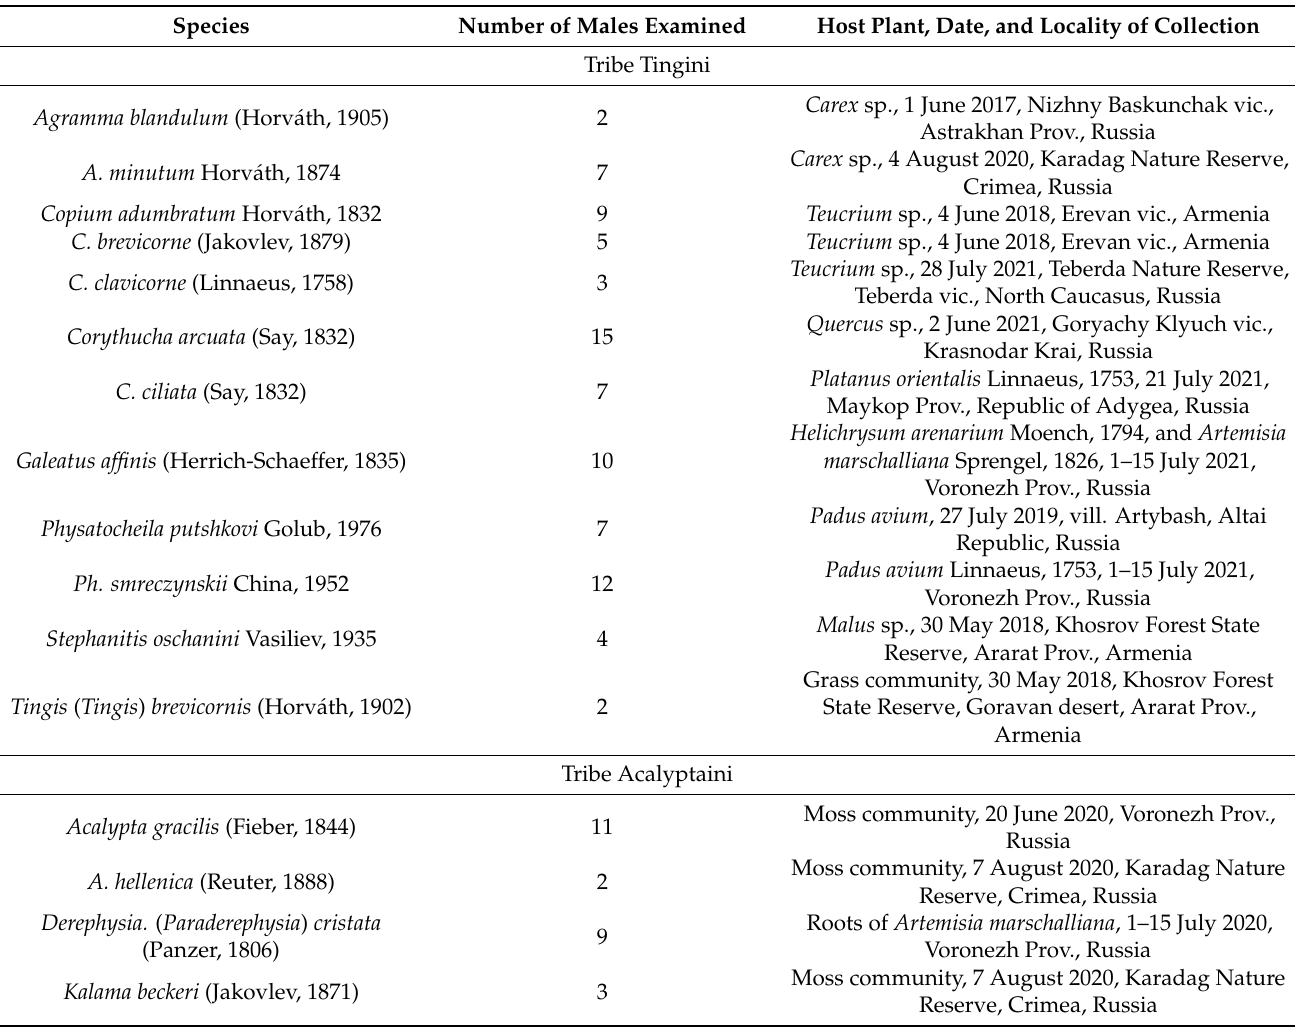
Table 1. Material used for chromosomal